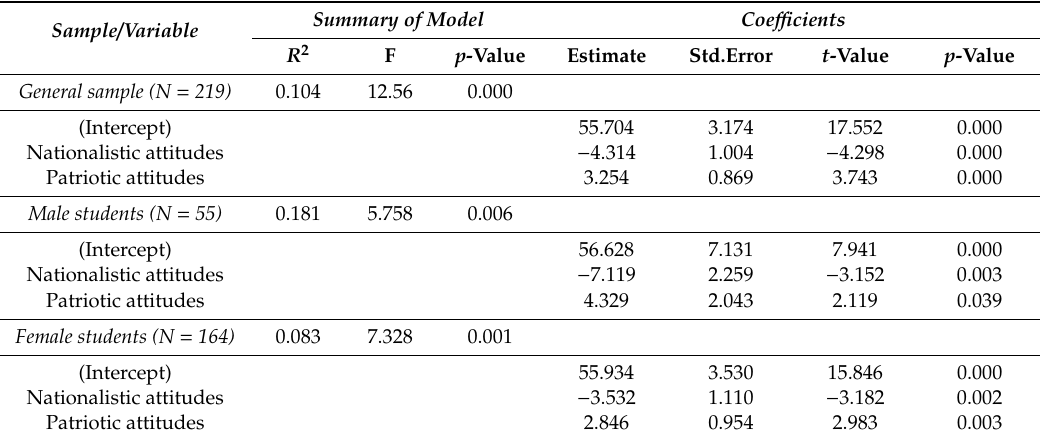
Table 2. Best predictor regression models for Acceptance subscale of ISS.